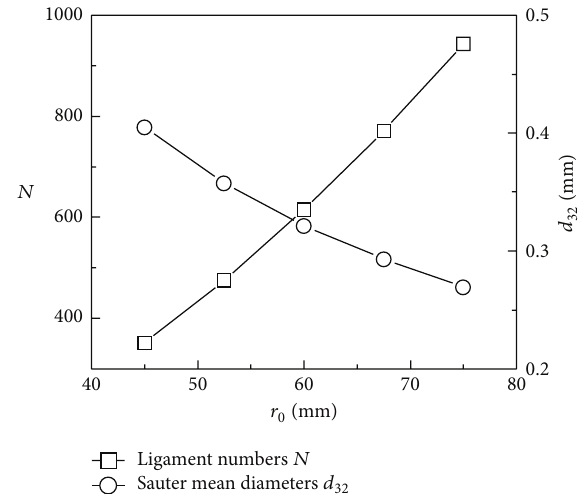
Figure 14: Variation in ligament number and droplet SMD with rotating disk